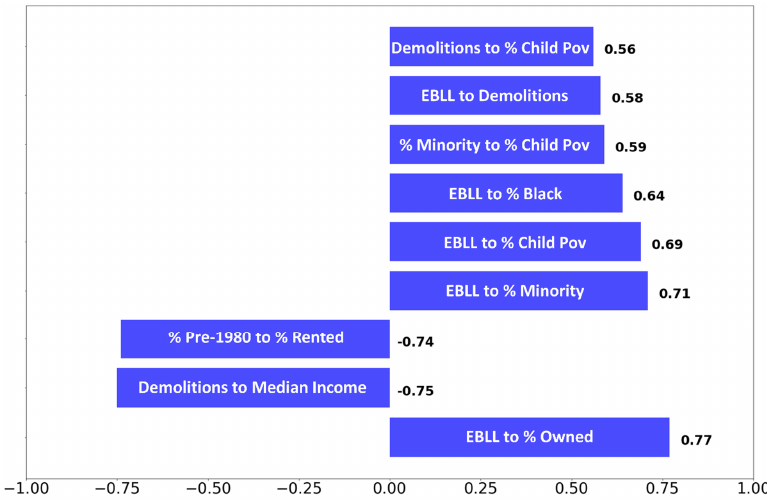
Figure 6. Box plot showing the strongest Spearman correlations present in the data set. Abbreviations: % Child Pov = % children in poverty; % Minority = % minority population; % Black = % Black population; % Owned = % owner-occupied properties; EBLL = % children with EBLL.